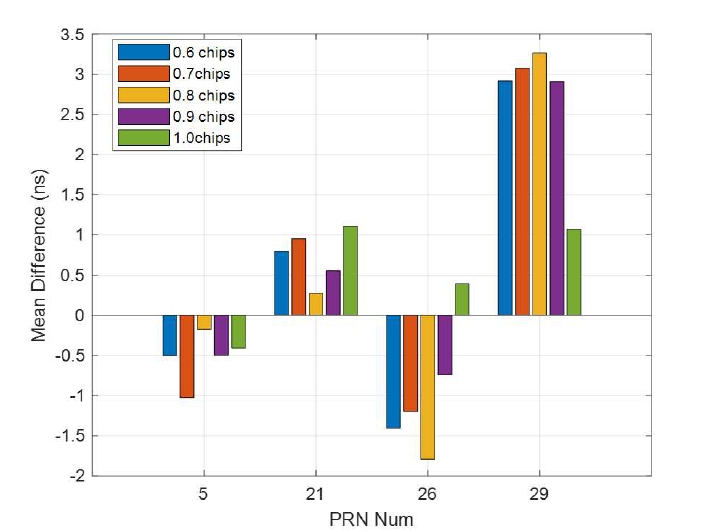
Figure 8. Mean difference between multi-station (4 IGS stations and 1 correlator spacing flexible receiver) estimated satellite DCBs and CODE products for 21:19–21:34, 16 August